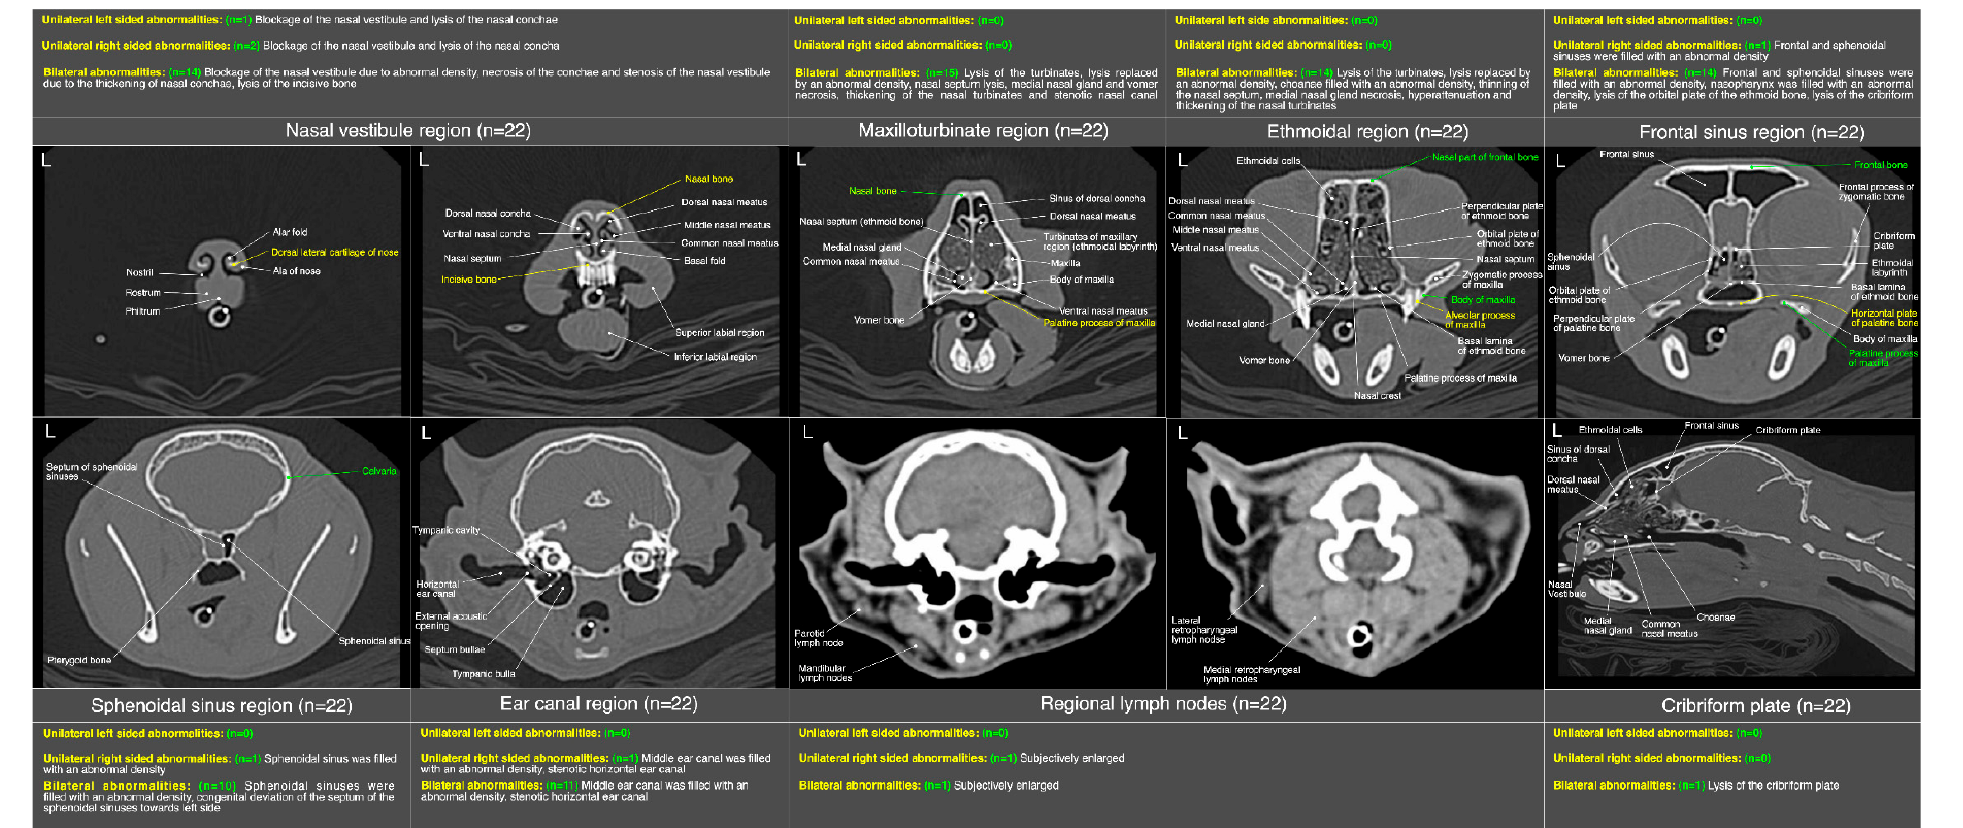
Figure 14. An illustrative summary of the localized computed tomographic abnormalities at focused regions of the skull in terms of their laterality in a total of 22 cats presented with acute/chronic infectious respiratory disease signs.